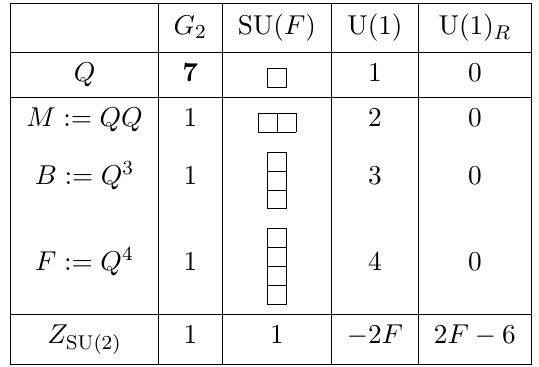
Table 6 . 3d N = 2 G 2 gauge theory with F fundamental